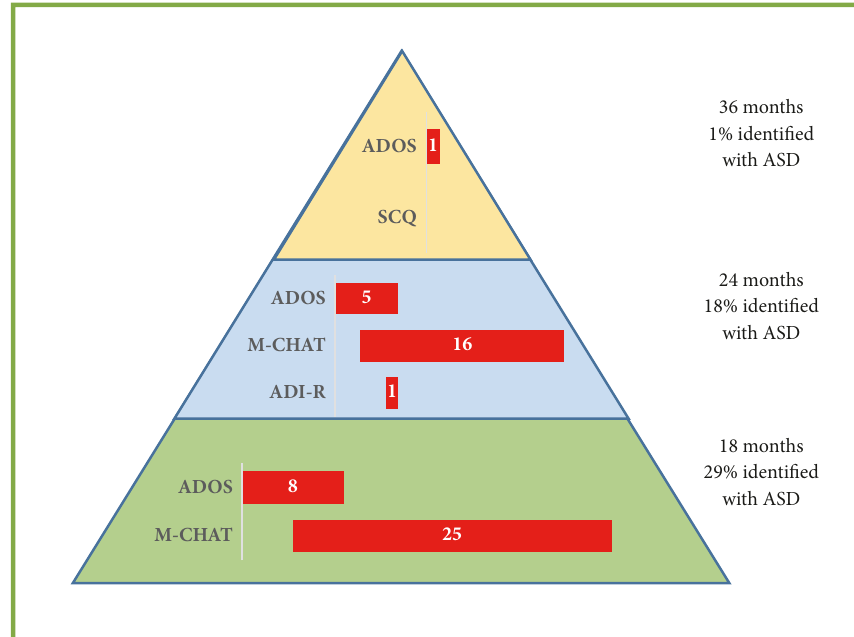
Figure 1: Prevalence of autism spectrum disorder risk among preterm children . Note . MCHAT: Modified Checklist for Autism in Toddlers, ADOS: Autism Diagnostic Observation Schedule, and ADI-R: Autism Diagnostic